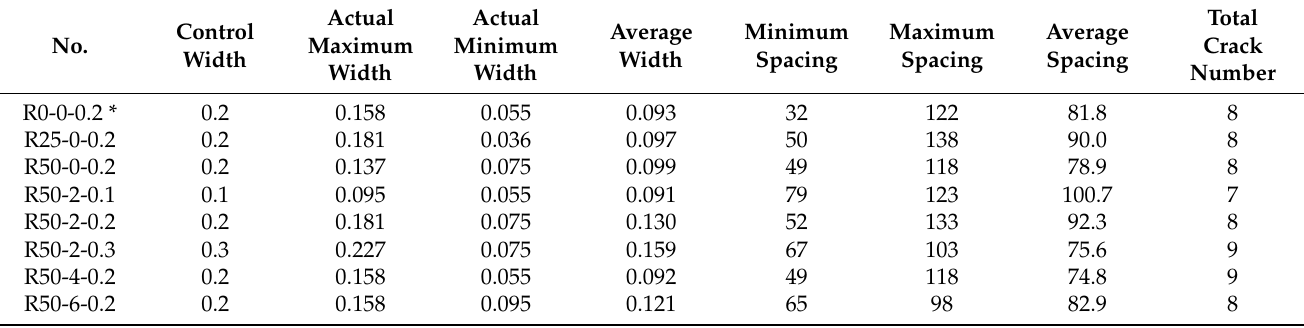
Table 5. Statistics of self-anchored cracks in the test beam (unit: mm).